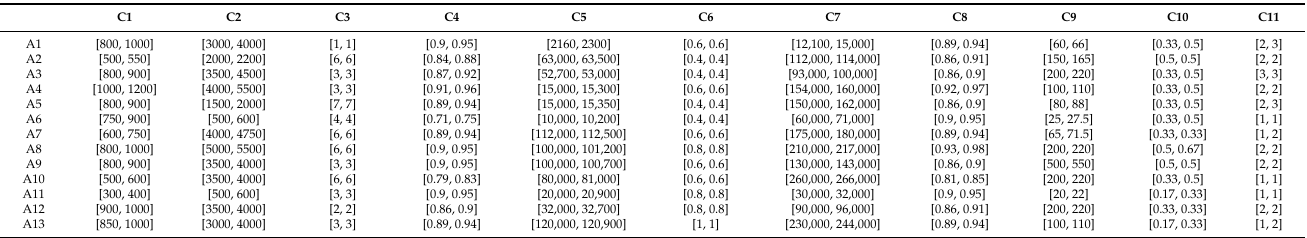
Table 6. Initial decision-making matrix.